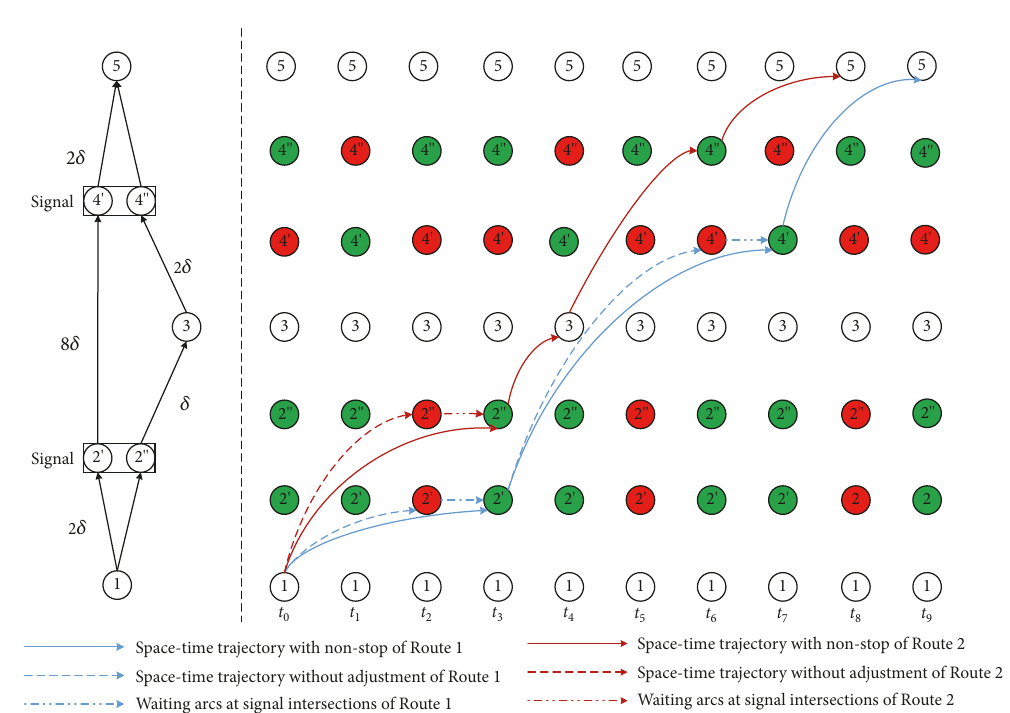
Figure 5: The simplified illustrative example of space-time